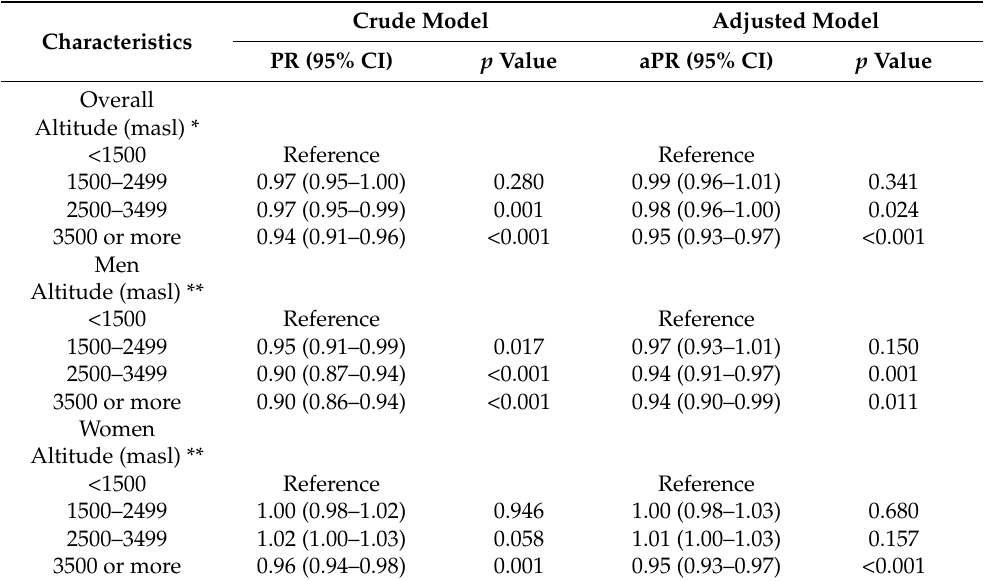
Table 4. Association between altitude and weight–height